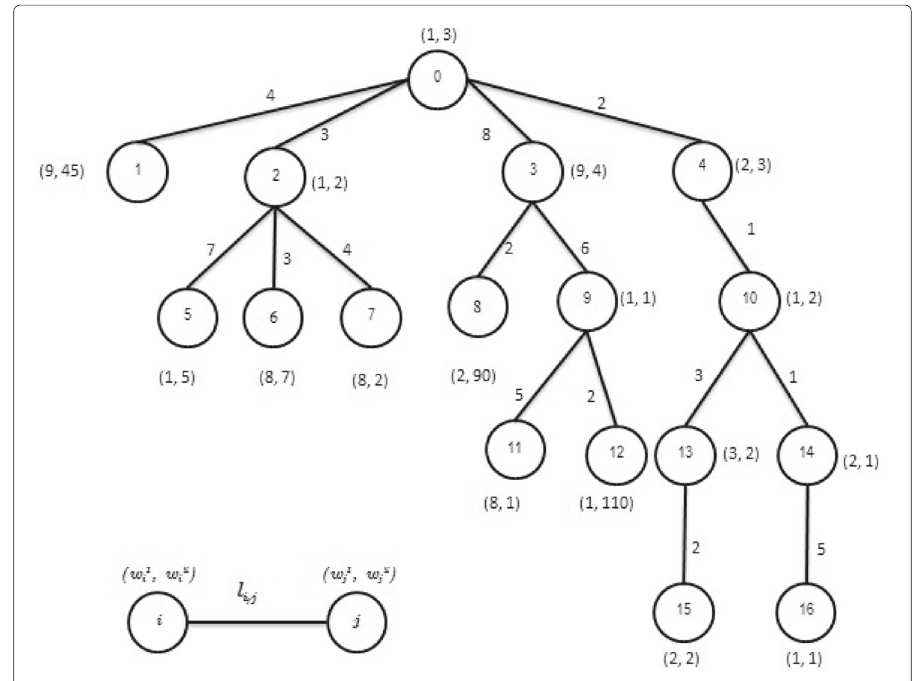
Fig. 5 Illustrative example